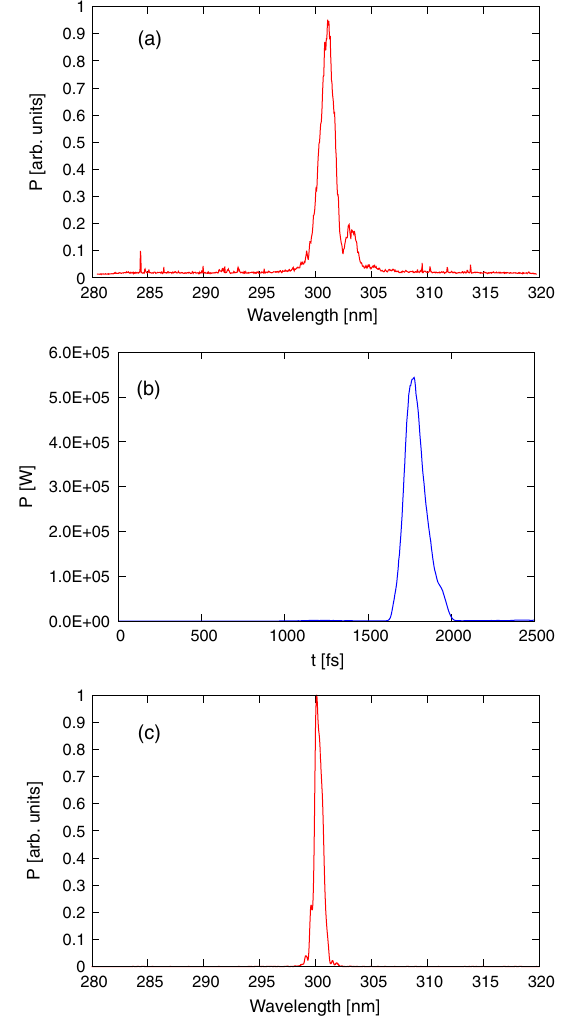
FIG. 8. Output radiation pulse and corresponding spectrum of the second stage: (a) measured spectrum, (b) simulation result of the pulse structure, and (c) simulation result of the